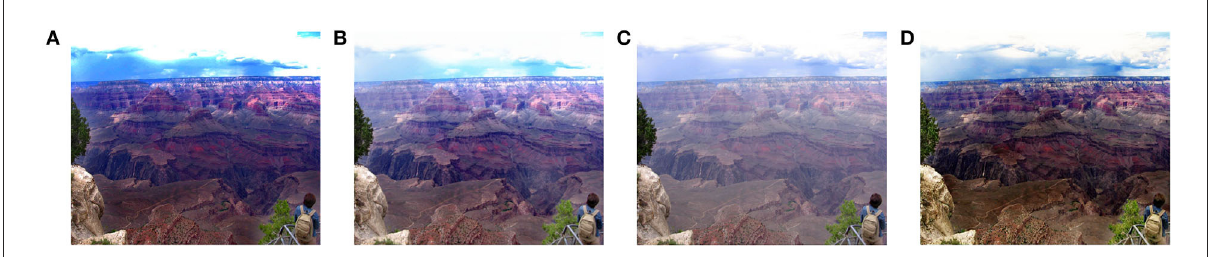
FIGURE1 Comparative results on a real-world image. (A) High contrast result with some color distortion generated by DCP. (B) High contrast result with some illumination distortion generated by DCPDN. (C) Under-dehazed result with better color fidelity generated by MSBDN. (D) Our result, which combines their